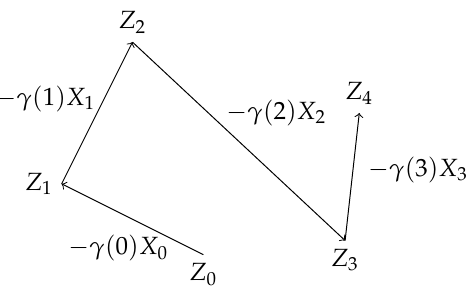
Figure 1. Path of stochastic process Z with director process X and learning rate γ